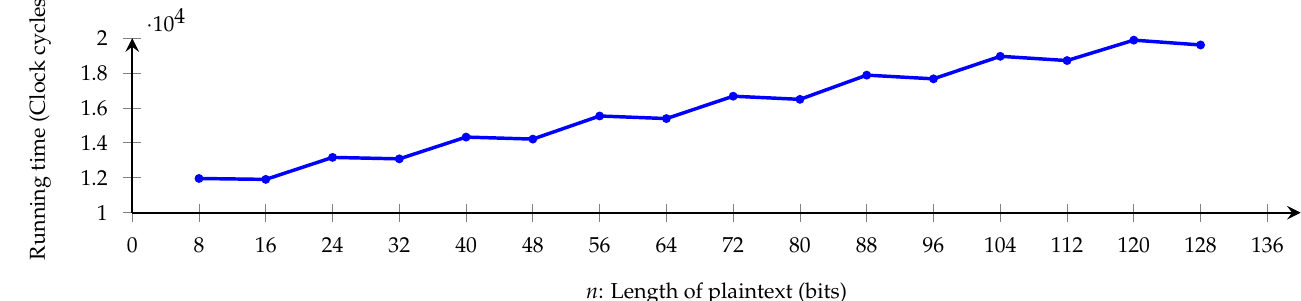
Figure 3. Differences of clock cycles depending on input n with AVR